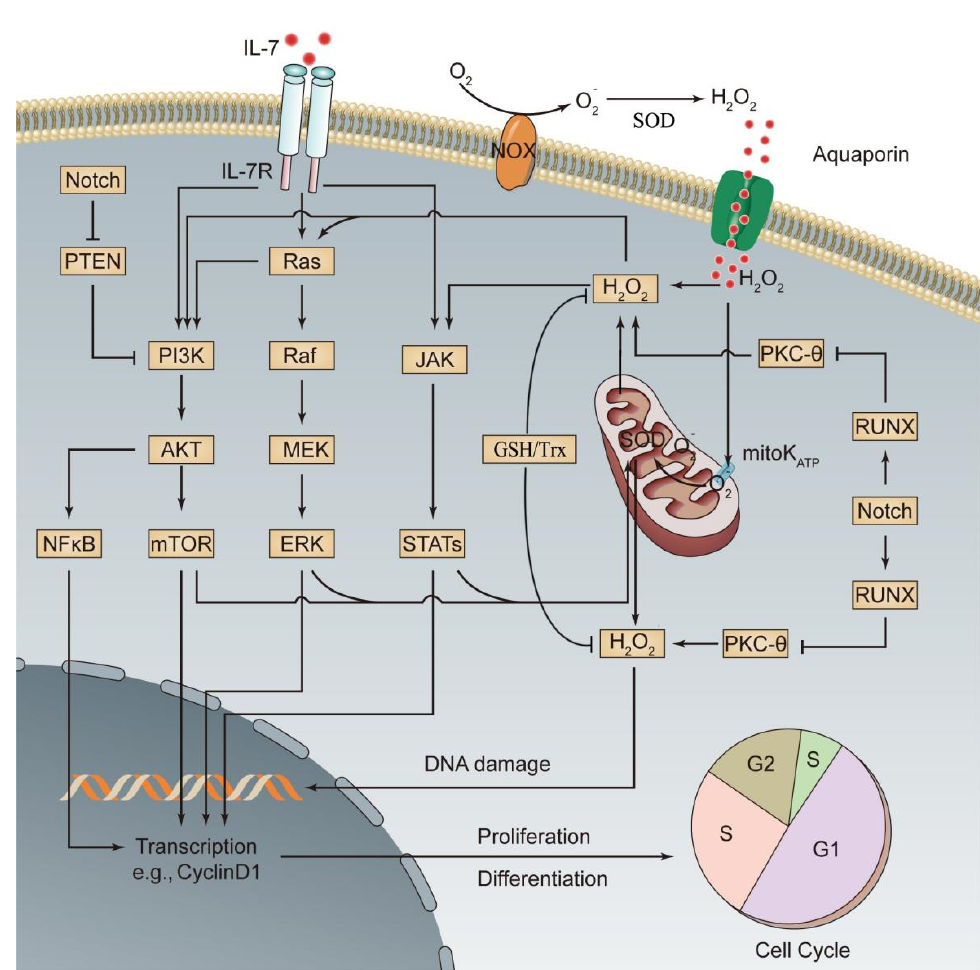
Figure 2. Activated oxidative stress signaling pathways involved in the pathogenesis of ALL. Increases in oncogene-, chemical drug-, or radiation-induced ROS production or abnormal expression of relevant genes leads to activation of three major oxidative stress signaling pathways, PI3K, MEK, and JAK, thus promoting the differentiation and proliferation of leukemia cells. Additionally, activation of oxidative stress signaling pathways promotes mitochondrial ROS production through enhanced oxidative metabolism, which further activates the three oxidative stress signaling pathways, thereby forming a positive feedback signaling pathway. A series of mechanisms in leukemia cells prevent excessive ROS production, thus avoiding cell injury or death (see the text for details). This figure was drawn based on existing research data; its accuracy and more precise signaling mechanisms must be confirmed and supplemented by extensive, in-depth studies. mitoK ATP , mitochondrial ATP-sensitive K +